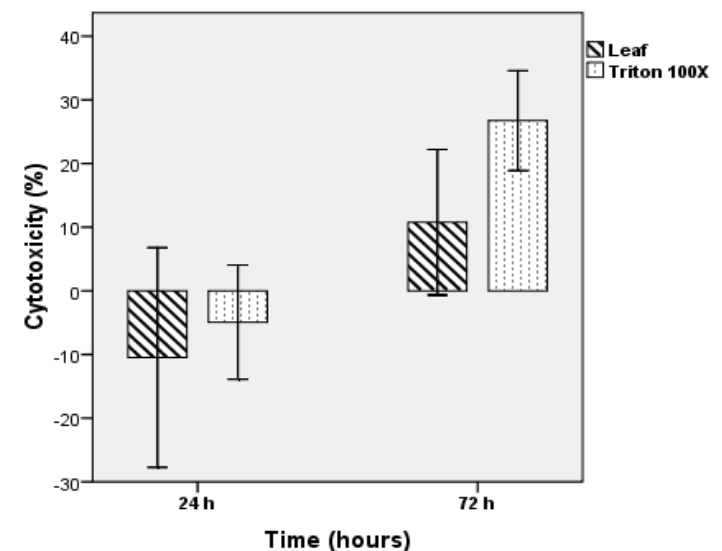
Figure 6. Total cytotoxicity activity of Vero cells after two different periods of treatment with leaf extract of L. camara and Triton 100× followed by MTT